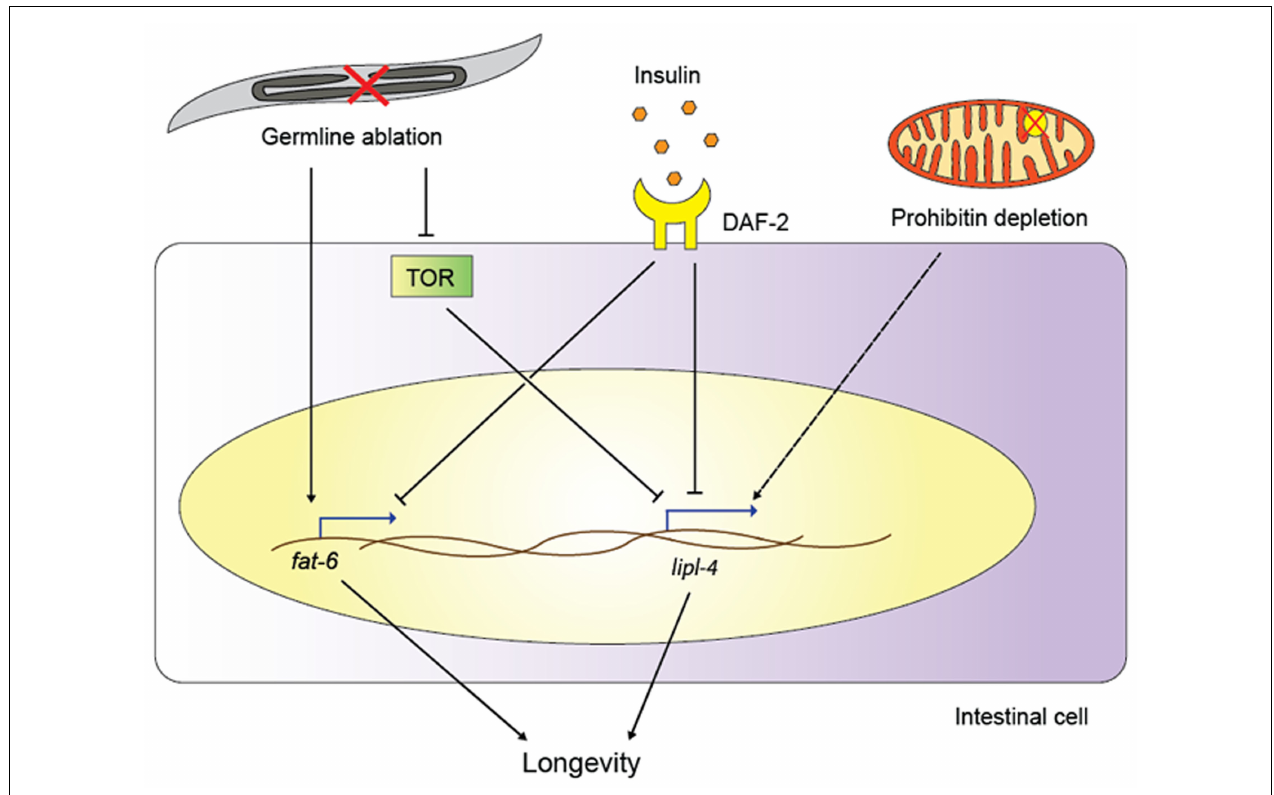
both germline-less worms and daf-2 /insulin receptor mutants. Prohibitin depletion extends the life spans of various C. elegans longevity models, possibly also relying on lipase action (as indicated by the dashed line; for details, see main